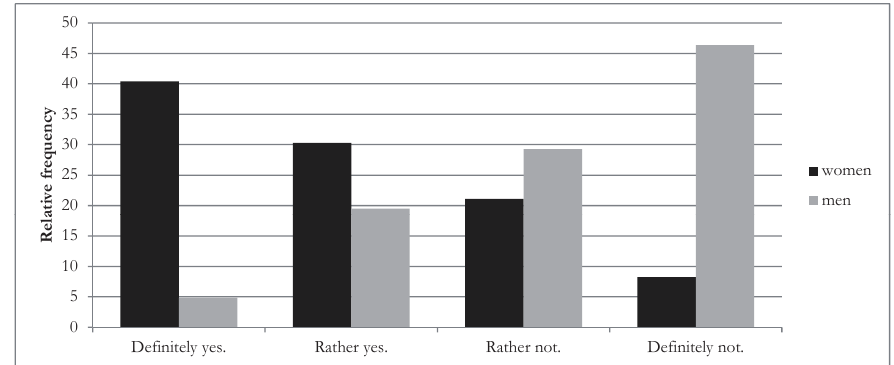
Fig. 8 - Opinion on quotas by men and women. Source: own processing,